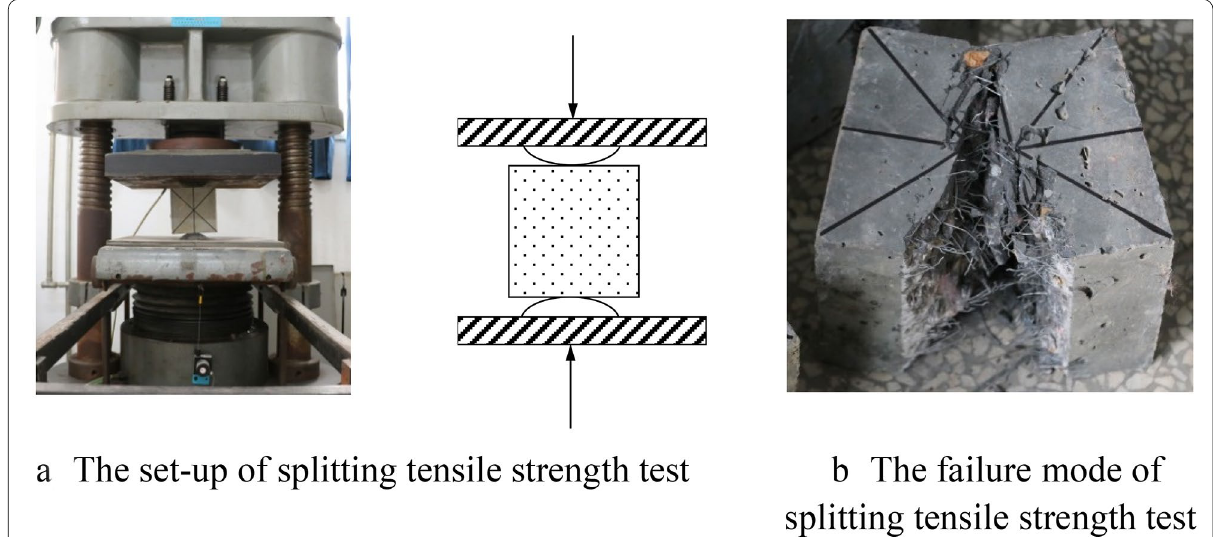
Fig. 4 The set-up and failure mode of splitting tensile strength